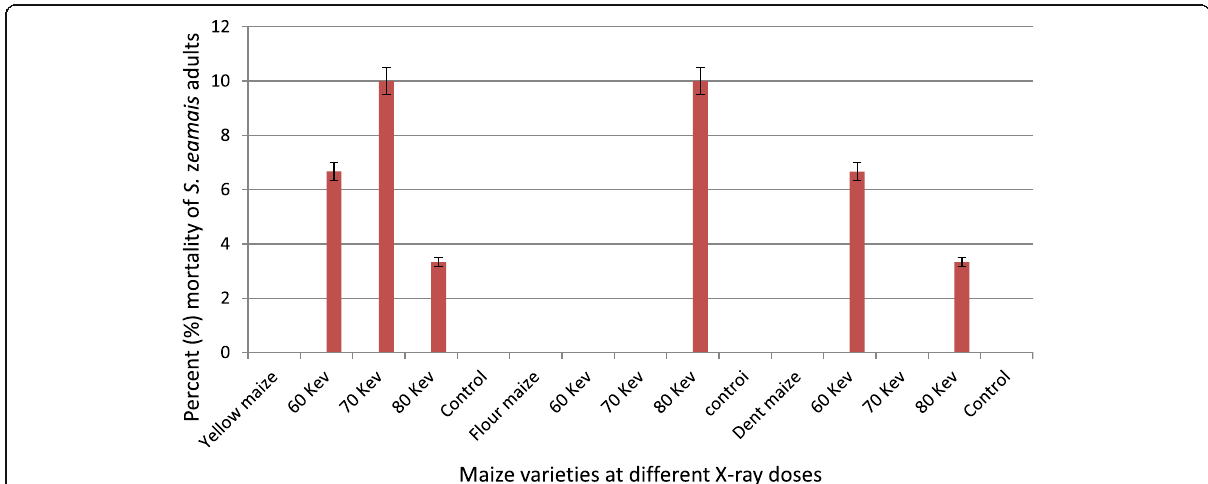
Fig. 1 Effect of X-ray exposure dose (KeV) on the mortality of Sitophilus zeamais Motschulsky adults after 24